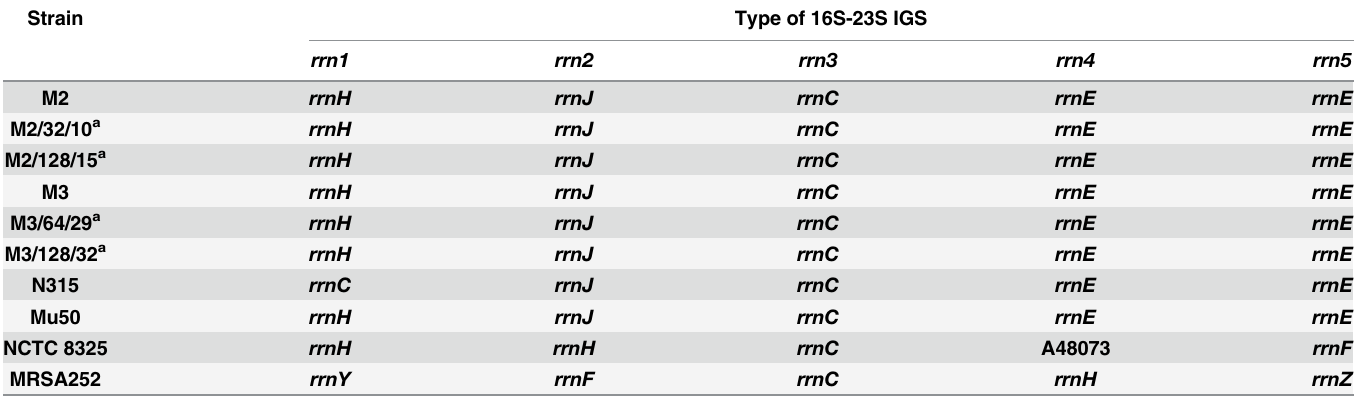
Table 6. Pattern of 16S-23S IGS regions in parental strains and isogenic linezolid (LZD)-resistant mutants.